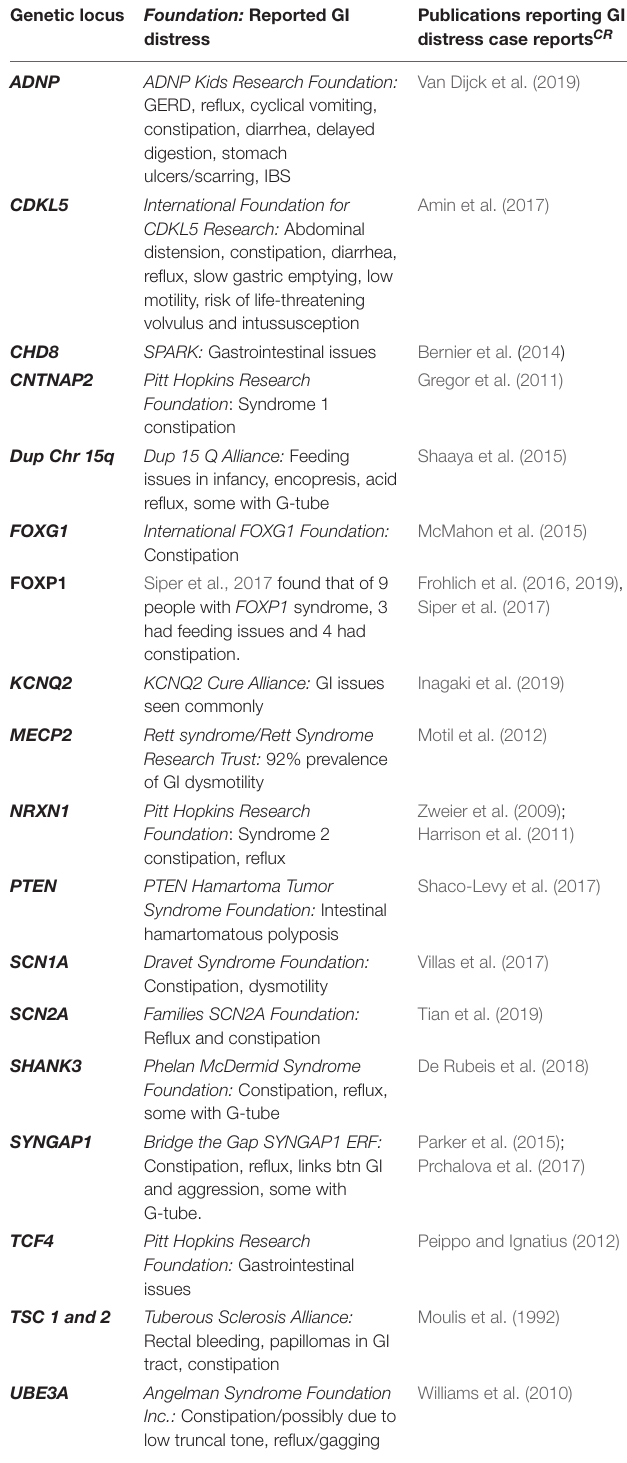
TABLE 1 | Molecularly-defined forms of ASD with GI